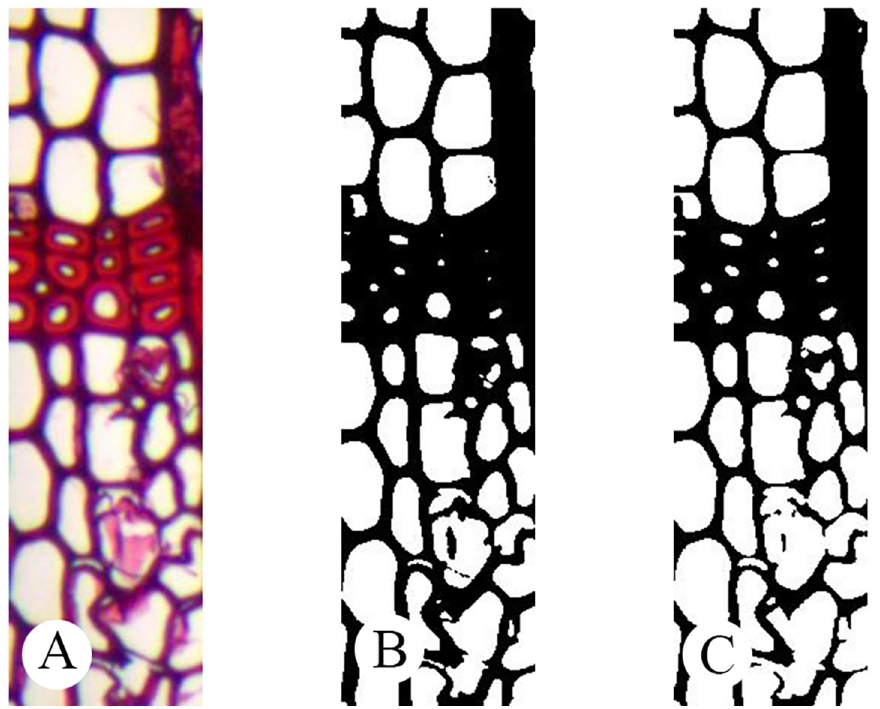
Fig 14. Comparison results of binarization. -A: Original; -B: Processing by an automatic threshold value; -C: Processing by a non-automatic threshold value.